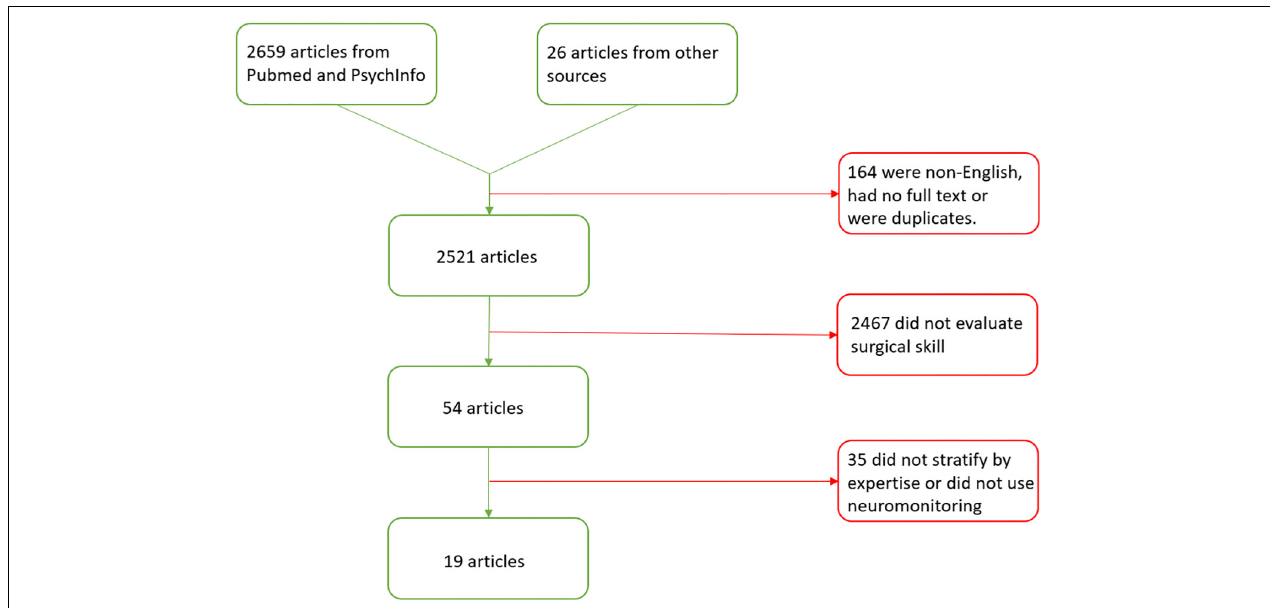
FIGURE 2 | Preferred reporting items for systematic review and meta-analysis (PRISMA) flow diagram for articles evaluating the neural mechanisms of surgical